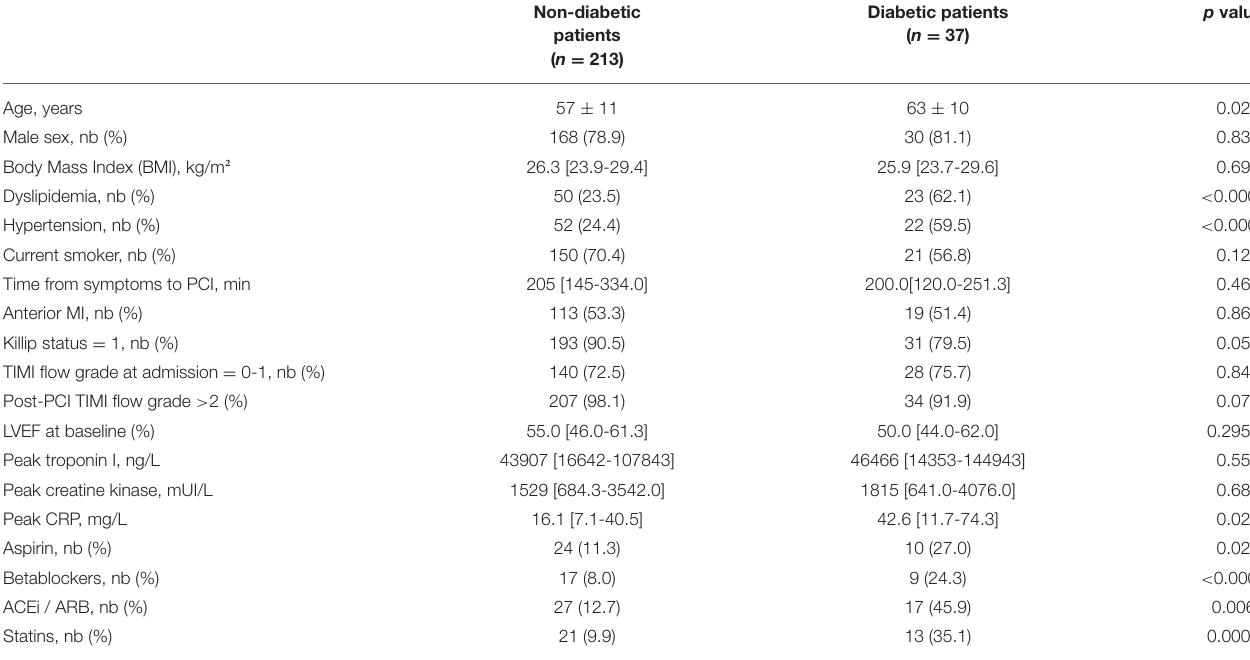
TABLE 1 | Characteristics of the study population.